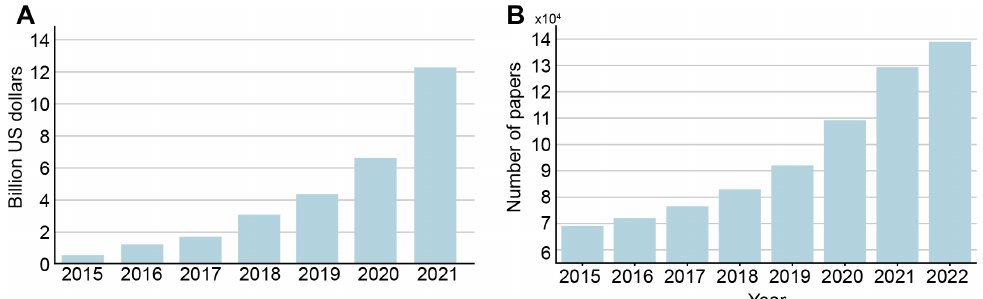
Figure 1. ( A ) dynamics of venture capital investment in artificial intelligence systems for medicine and healthcare, according to CB Insights, USD billion. Based on data from ‘State of AI 2021 Report’ [Internet]. Source: https://www.cbinsights.com/research/report/ai-trends-2021/ (accessed on 21 September 2022). ( B ) dynamics of number of AI in medicine papers by year indexed in the PubMed